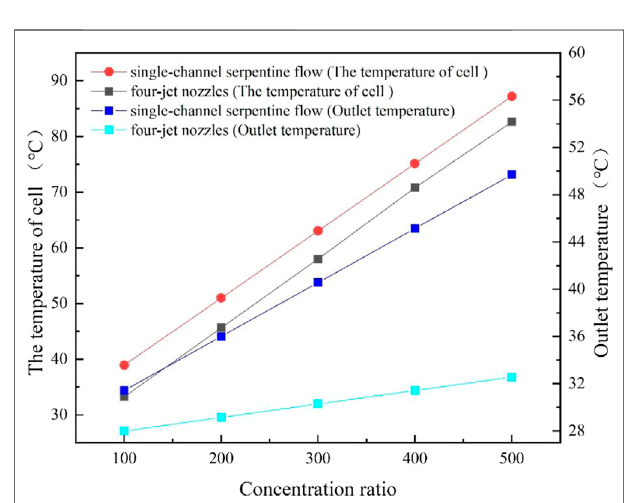
FIGURE 10 | In fl uence of concentration ratio on temperature uniformity ofcellunderthefour-jetnozzles,single-channelserpentine fl ow,andsingle-jet